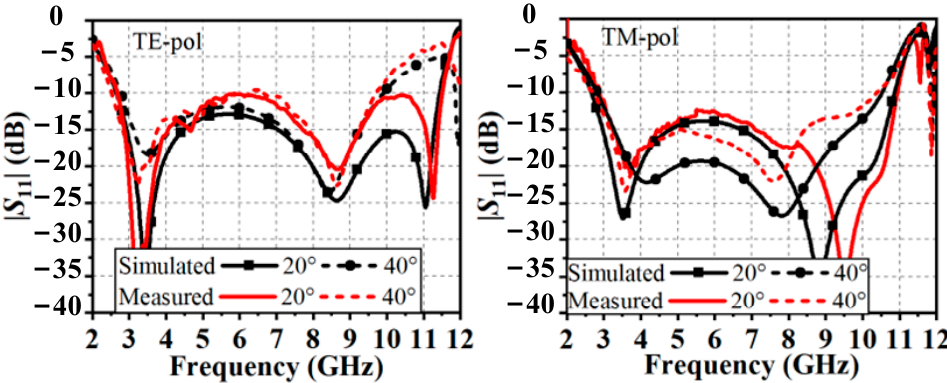
Figure 10. Simulated and measured | S 11 | of the proposed 3D absorber under the oblique incidences.